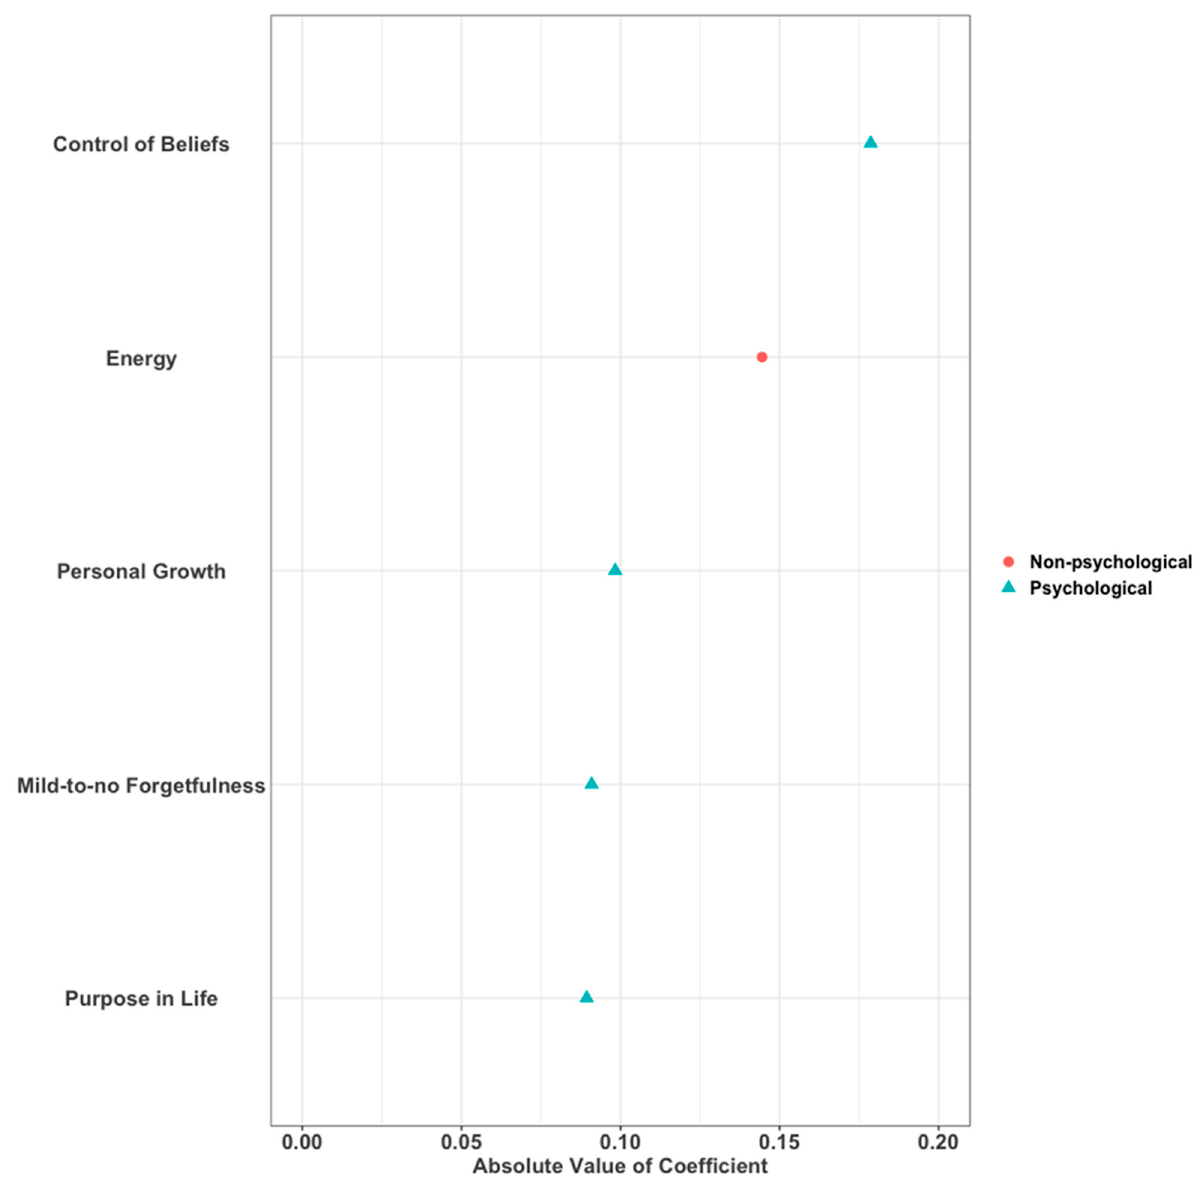
Figure 2. Ranking of variable importance in Elastic Net model using all variables (Top 5 variables from Model E1 shown).